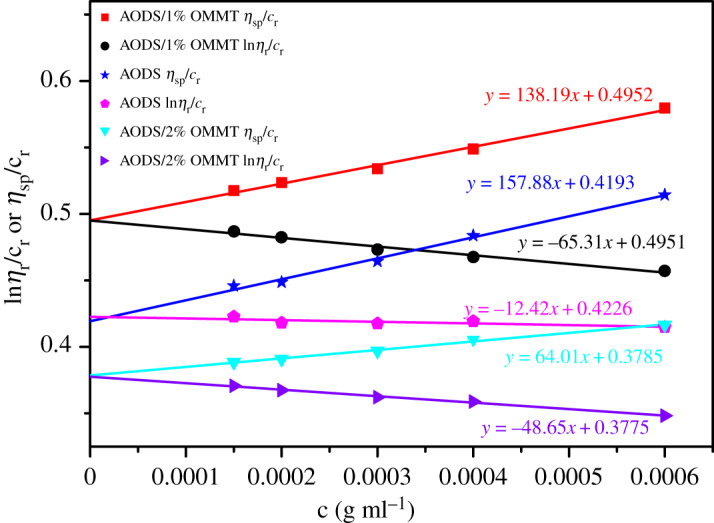
The function relationship between ηsp/cr or lnηr/cr and c (samples).